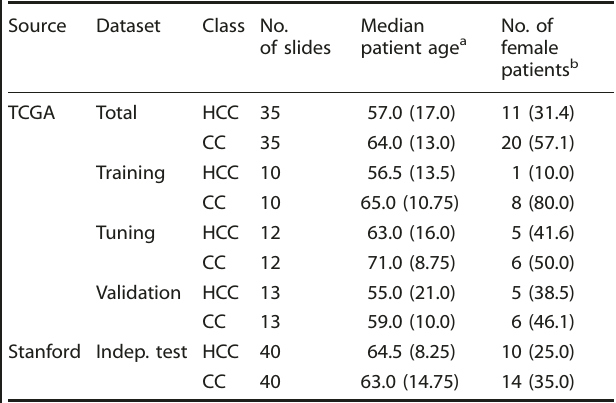
Table 1. Dataset and patient characteristics.